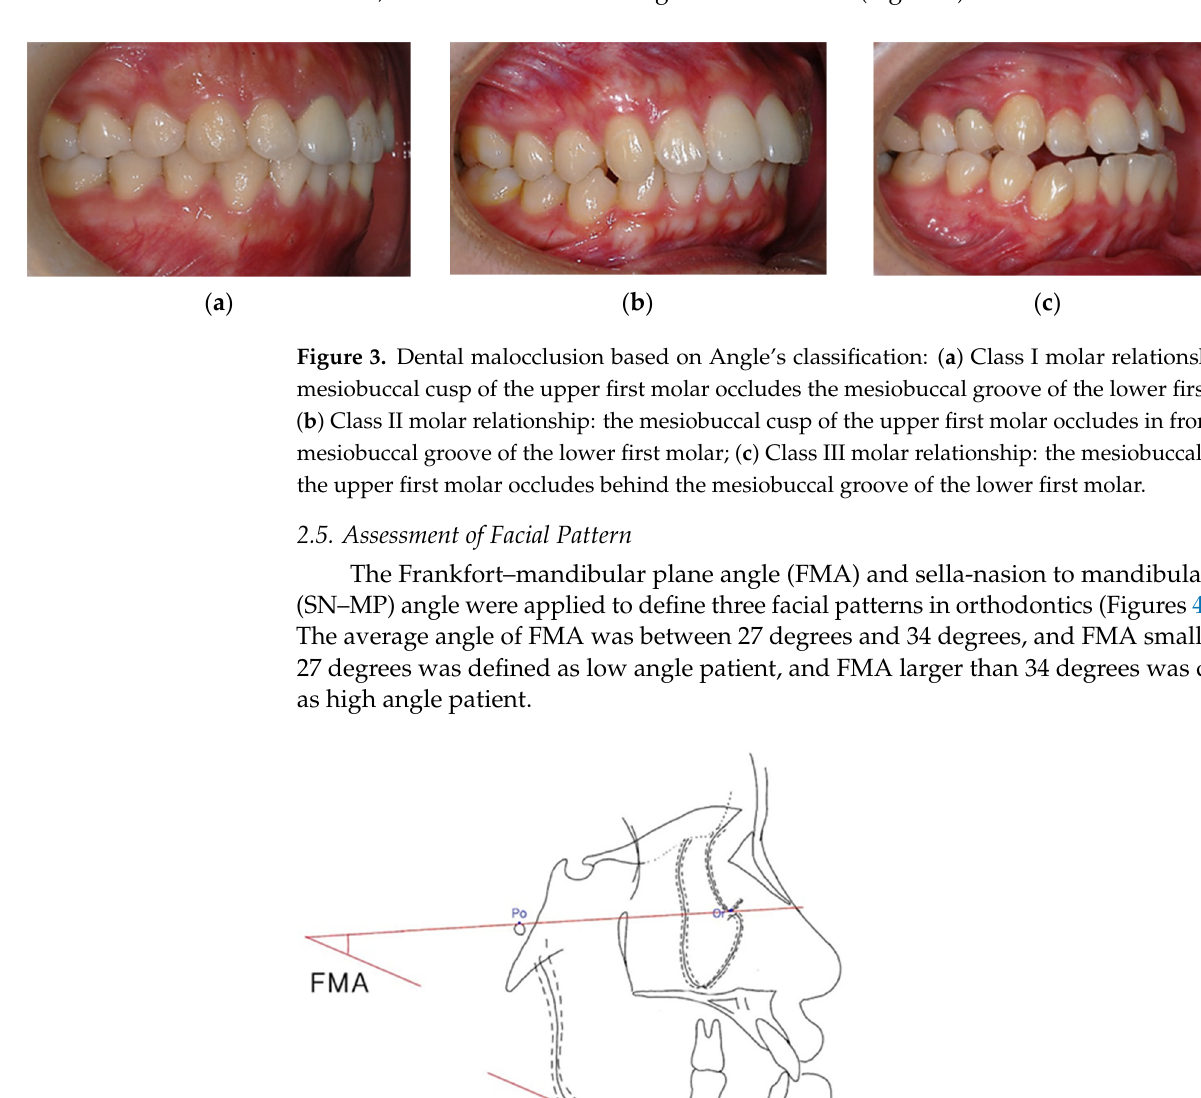
Figure 2. The sagittal skeletal relationship was classified as Class I, Class II, or Class III based on the ANB angle, which was formed by the A point, Nasion, and B point: ( a ) Class I relationship: ANB angle was 2–4 degrees; ( b ) Class II relationship: ANB angle was larger than 4 degrees; ( c ) Class III relationship: ANB angle was smaller than 2 degrees.